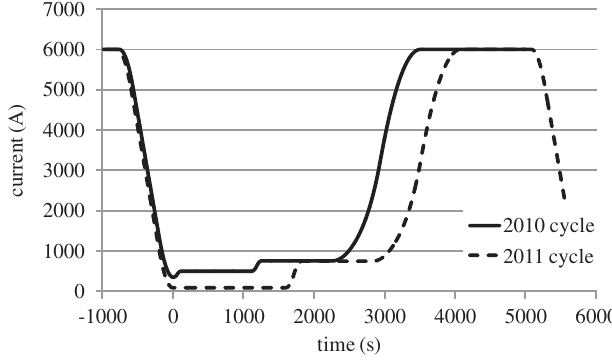
FIG. 4. Difference between the operation cycle used in 2010 and 2011. The 0 s mark represents the point where the reset current is reached.